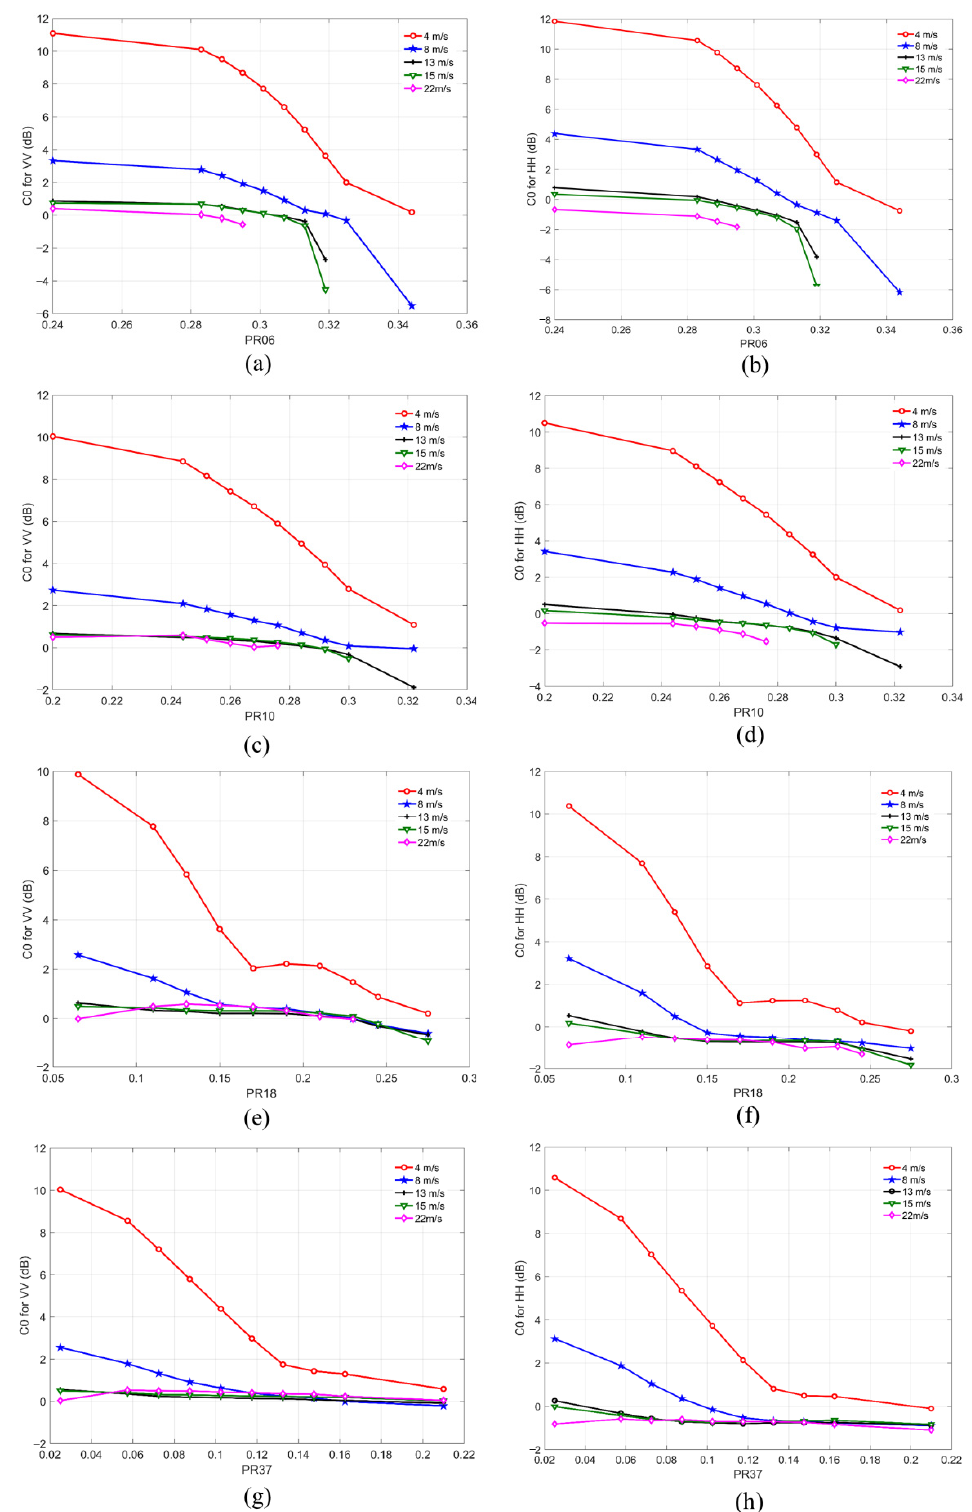
Figure 2. The coefficient c 0 versus PR: ( a ) 6.925 GHz at VV polarization; ( b ) 6.925 GHz at HH polarization; ( c ) 10.7 GHz at VV polarization; ( d ) 10.7 GHz at HH polarization; ( e ) 18.7 GHz at VV polarization; ( f ) 18.7 GHz at HH polarization; ( g ) 37.0 GHz at VV polarization; ( h ) 37.0 GHz at HH polarization.